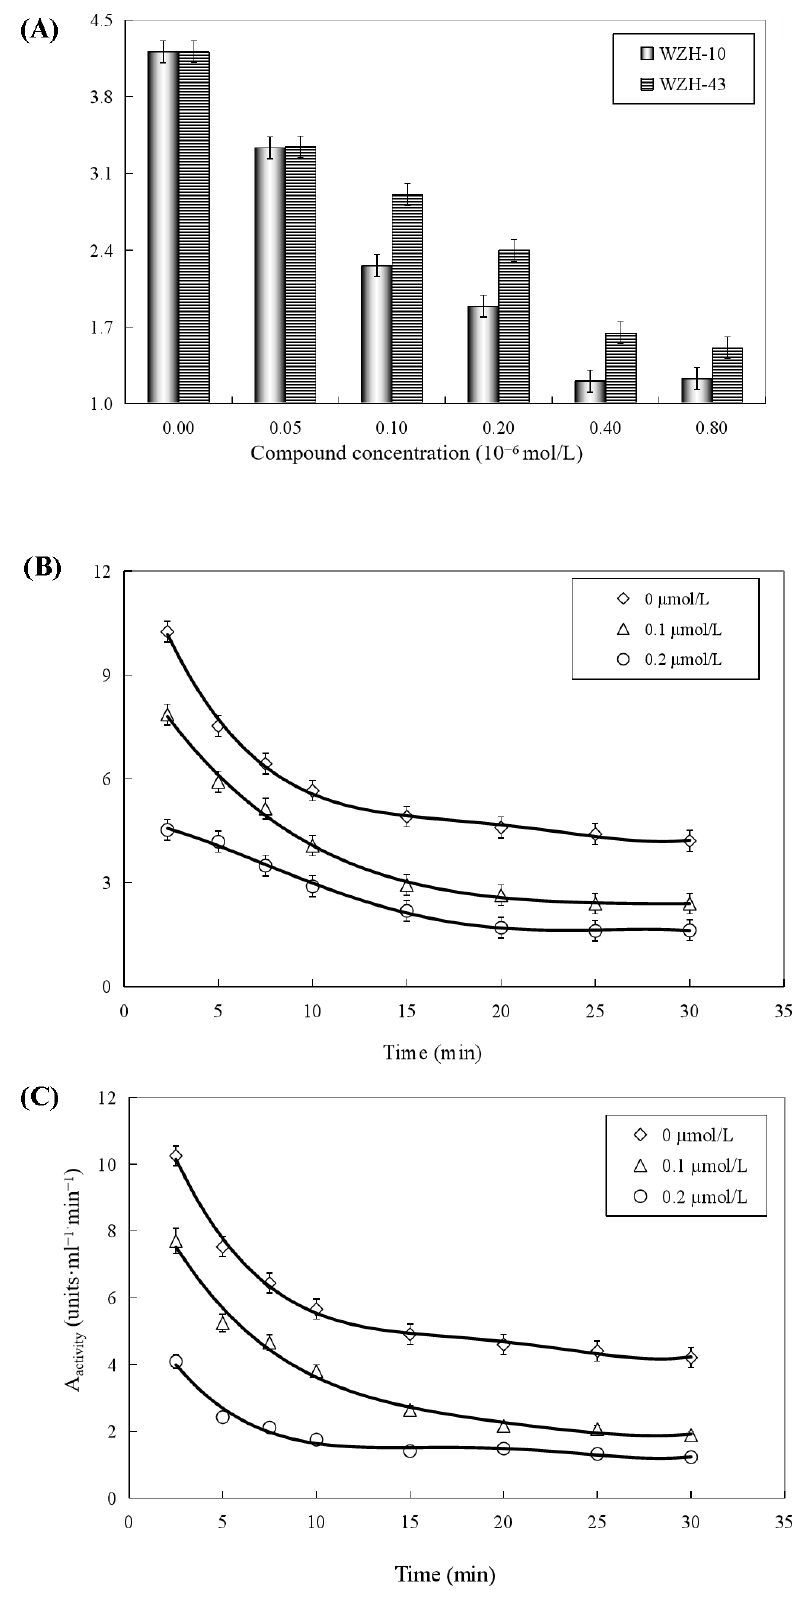
Figure 8. Concentration-dependent ( A ) and time-dependent inhibitory effect of WZH-43 ( B ) and WZH-10 ( C ) on the ATPase activity of BLM helicase. Table 1. Effects of the two prenylated chalcones on the ATPase activity of BLM helicase.